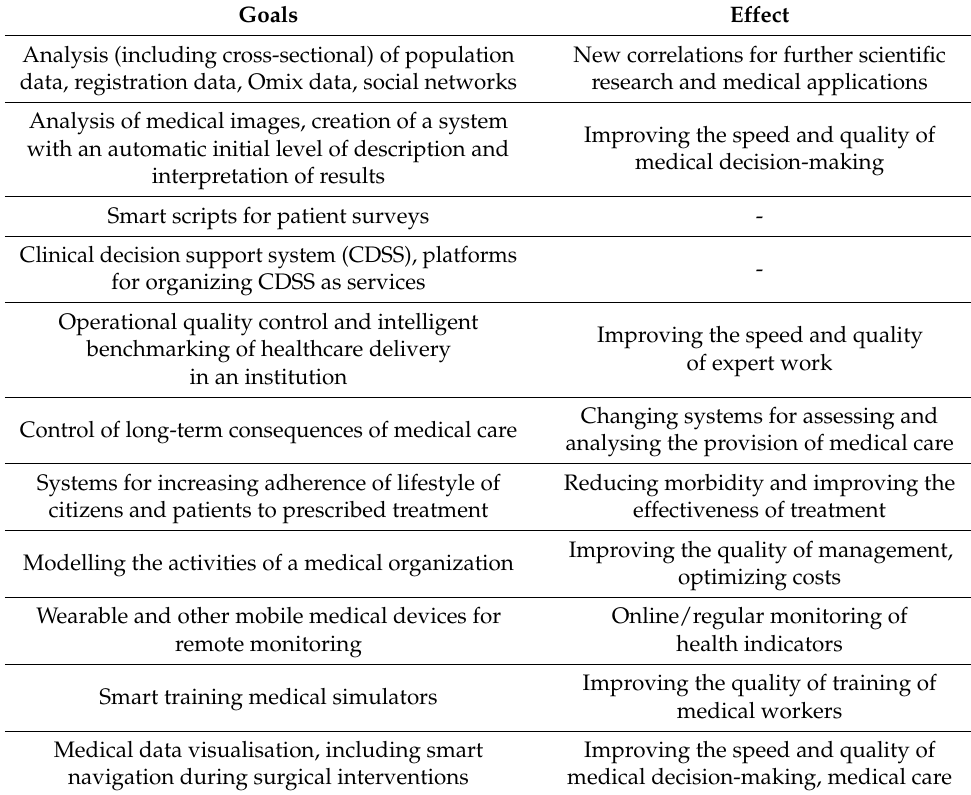
Table 4. Areas leveraging AI in